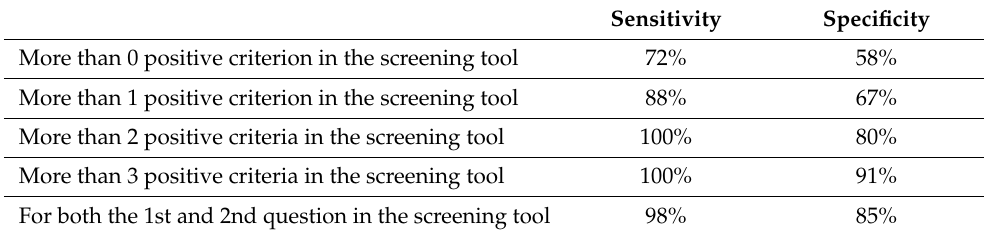
Table 2. Sensitivity and specificity of the Questionnaire for Binge Eating Screening